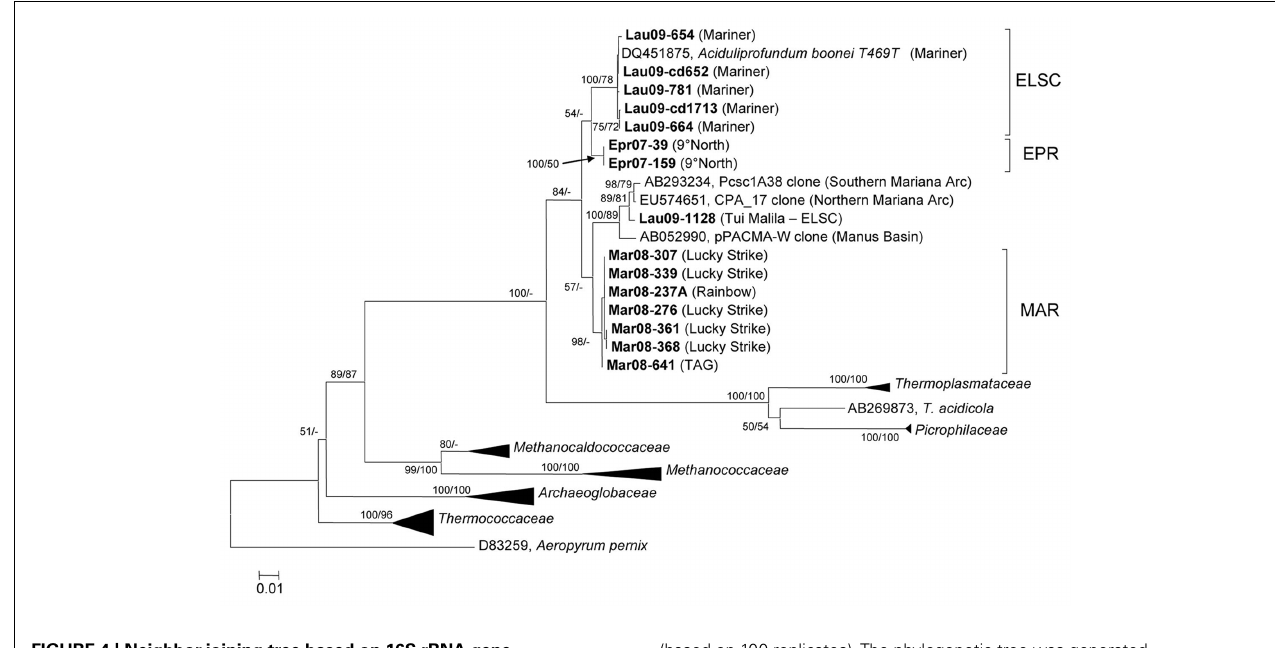
FIGURE 4 | Neighbor-joining tree based on 16S rRNA gene sequence comparisons of novel DHVE2 isolates and other archaeal families. Note that strains MAR08-276, MAR08-307, and MAR08-361 were not included in MLSA analysis as ambiguities were observed in protein-coding genes but not in 16S rRNA gene sequences. Bootstrap percentages above 50% are shown for the neighbor-joining analysis (based on 500 replicates) and for the maximum-likelihood analysis